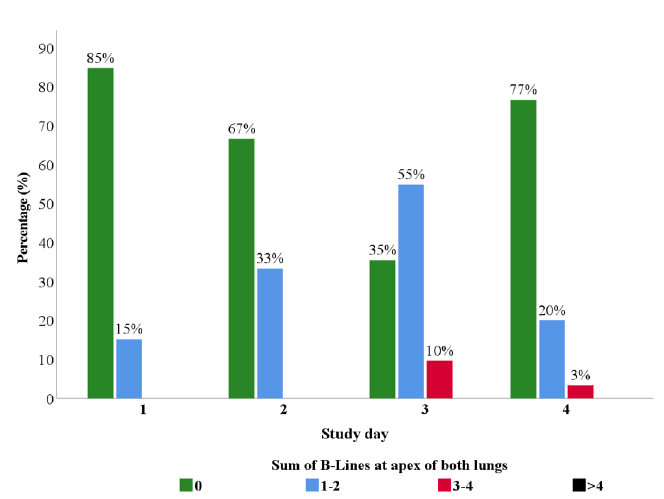
Figure 2. Distribution of the sum of B-lines at the anterior apex of both lungs over four days at